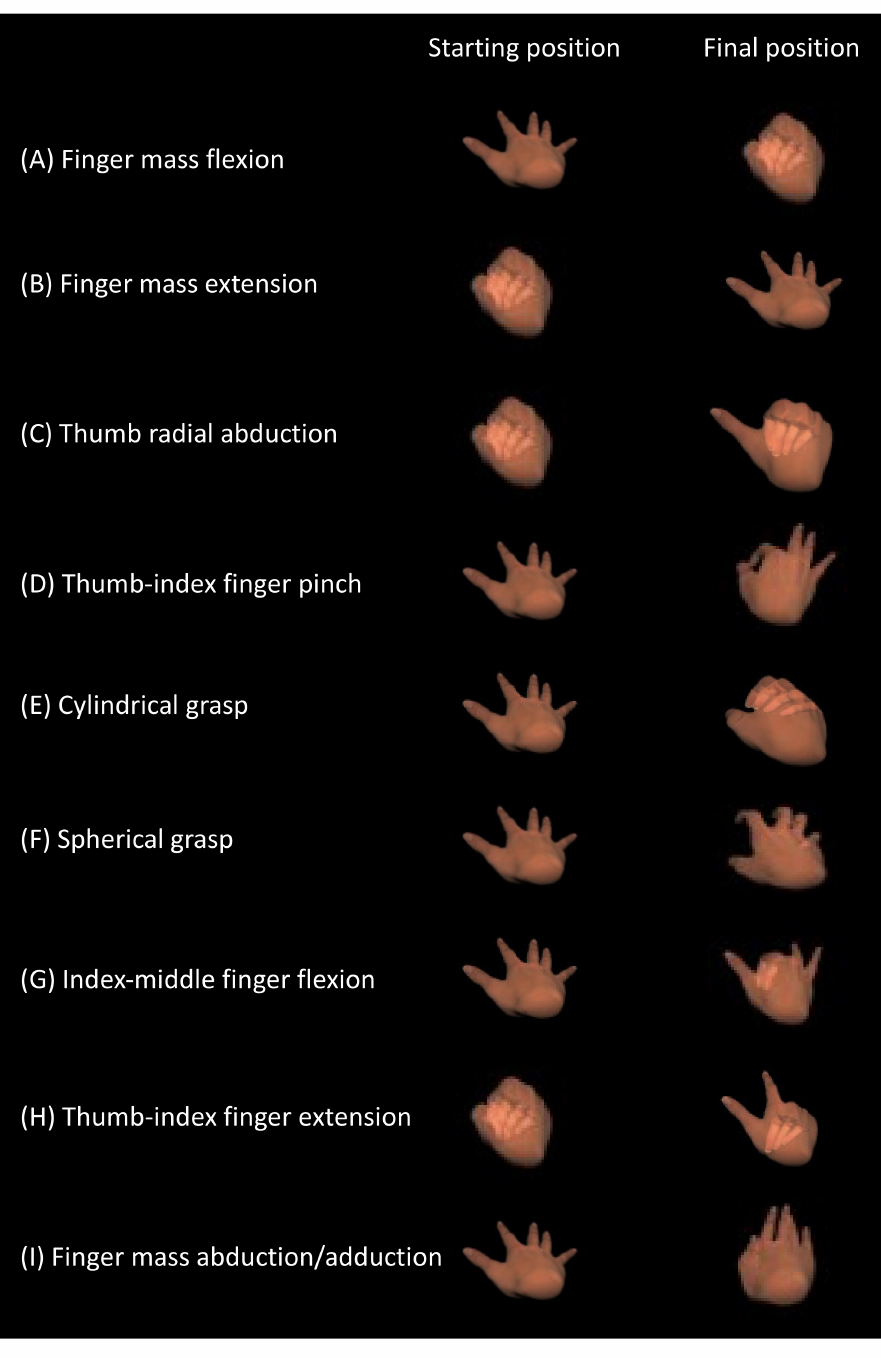
Figure 1. The nine tasks of the BRS assessment. Patients were placed in a sitting position during the recordings, on a chair or wheelchair, with the shoulder joint in a resting position [13], the elbow joint at approximately 90 ◦ , the forearm pronated, and the wrist joint in the neutral position (Figure 2A). We instructed each participant to assume the starting position for each task at a distance of approximately 20 cm above the LMC, and to maintain the starting position for 5 s from the start signal while looking at the laptop monitor. After 5 s, a verbal signal directed the participant to move their hand to the best of their ability to achieve the hand position for each task, and then to maintain their maximum attained position for 15 s from the start signal.